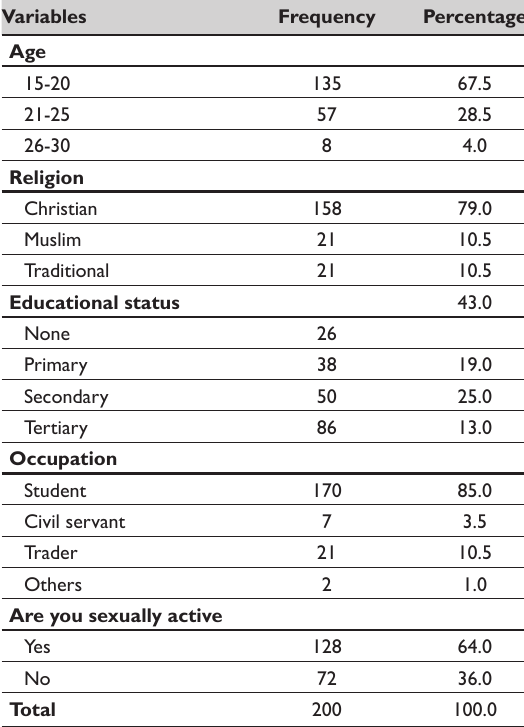
Table 1. Sociodemographic characteristics of the